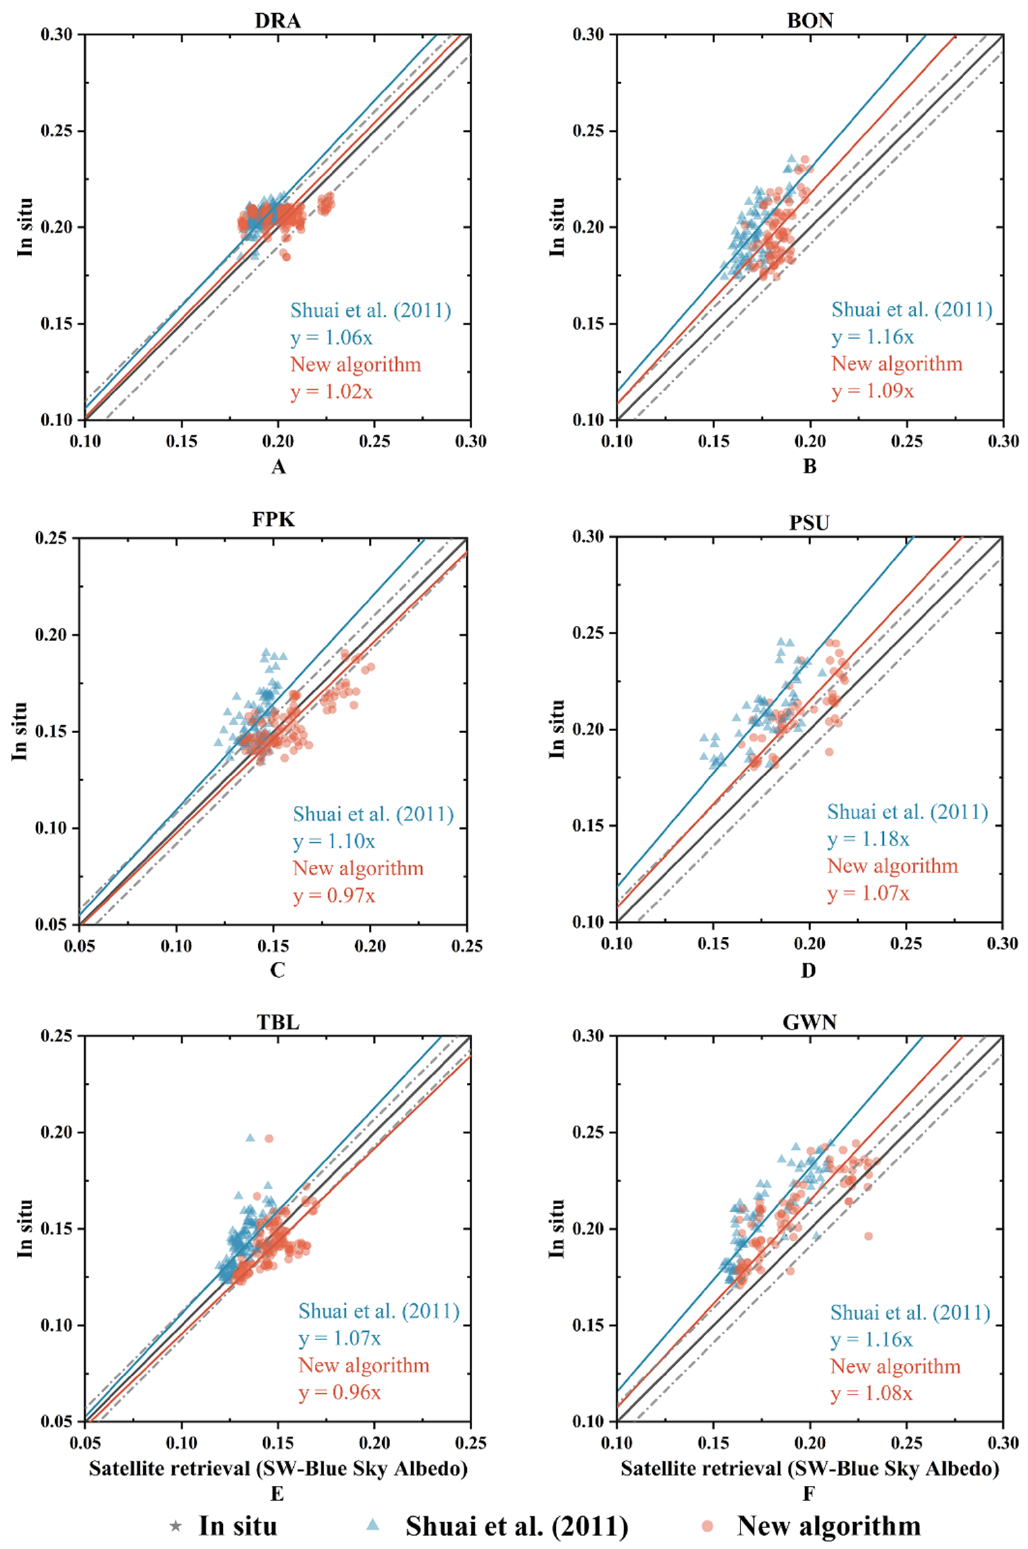
Figure 6. Validation of concurrent approach and new algorithm albedo products using in situ data from each site. Dotted gray lines indicate 5% uncertainty of each site, solid lines are one-to-one lines. The slopes of the fitted lines were obtained by the least square method, with intercepts of all the fitted lines set to 0. ( A ): Desert Rock (DRA); ( B ): Bondville (BON); ( C ): Fort Peck (FPK); ( D ): Penn State University (PSU); ( E ): Table Mountain (TBL); ( F ): Goodwin Creek (GWN).